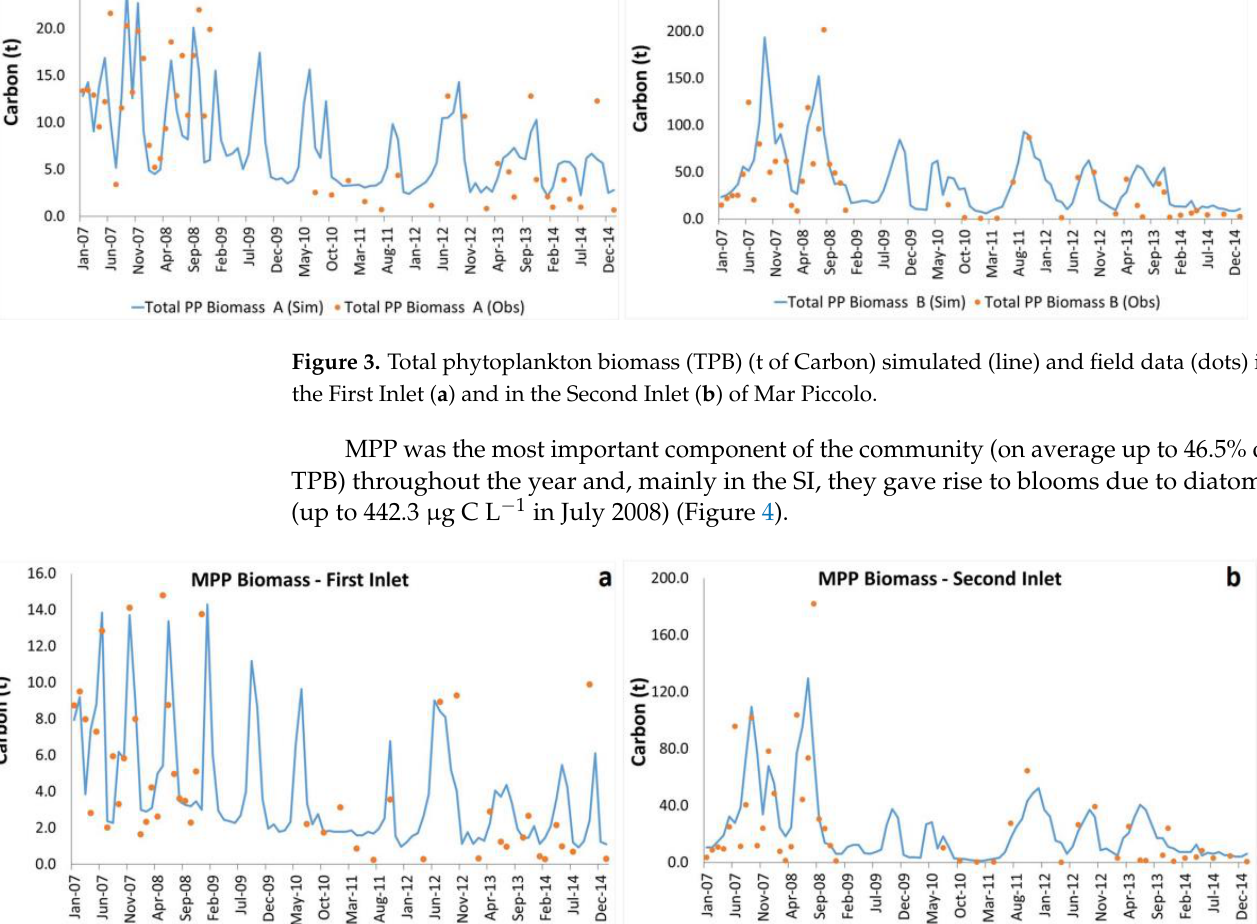
Figure 5. Nano-Phytoplankton (NNP) biomass (t of Carbon) simulated (line) and field data (dots) in the First Inlet ( a ) and in the Second Inlet ( b ) of Mar Piccolo. PPP biomass was usually negligible (on average up 21.8% of TPB), except in summer when they reached the maximum value of 92.5 μ g C L −1 , representing up to 47.5% of TPB (September 2007, SI) (Figure 6). Figure 6. Pico-Phytoplankton (PPP) biomass (t of Carbon) simulated (line) and field data (dots) in the First Inlet ( a ) and in the Second Inlet ( b ) of Mar Piccolo. To summarize these results, in Figure 7 are represented the ratio trends of the three phytoplankton size-fractions with respect to the total biomass.